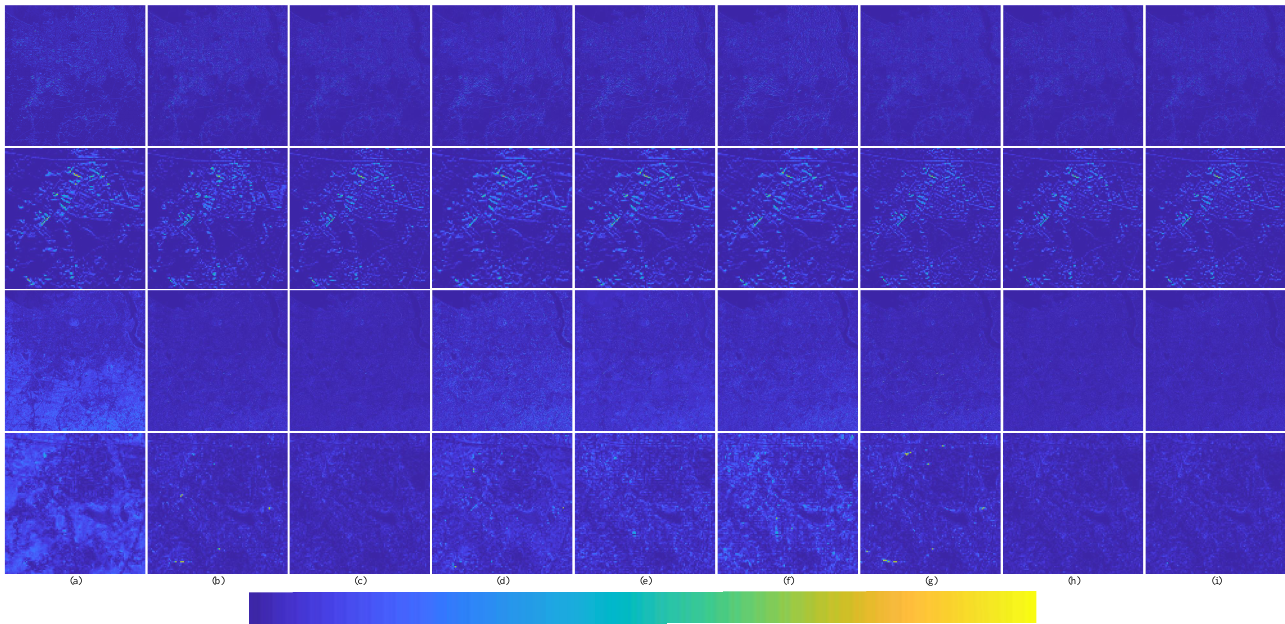
Figure 13. Average intensity difference maps and average spectral difference maps between a pan-sharpened MS image and ground-truth MS image for the Landsat-8 training dataset with reduced resolution; the top row are the average intensity difference maps of the whole image, the second row are the average intensity difference maps of the enlarged area in Figure 11, the third row are the average spectral difference maps of the whole image, and the bottom row are the average spectral difference maps of the enlarged area in Figure 11. ( a ) Brovey; ( b ) GS; ( c ) SFIM; ( d ) IFCNN; ( e ) PNN; ( f ) DRPNN; ( g ) PanNet; ( h ) ResTFNet; ( i ) RDFNet